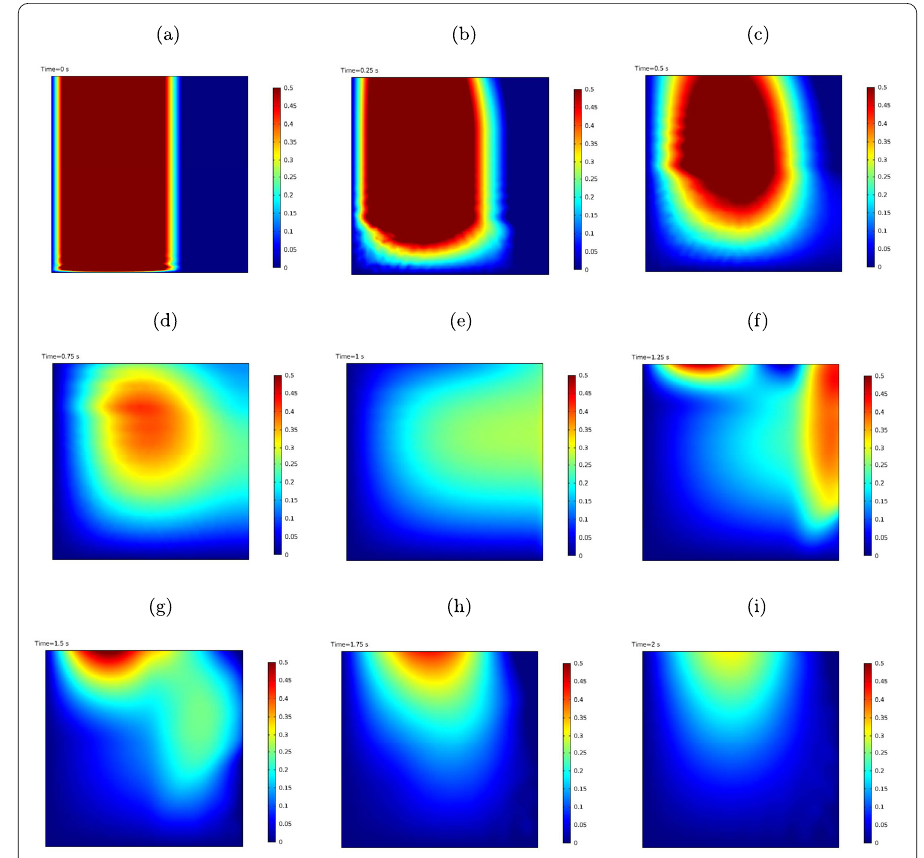
Figure 14 2-d solutions of the wave equation (1.16)-(1.20) with a delay τ = 1 when a ( x ) = 10 and k = 1, at several times: t = 0, ...